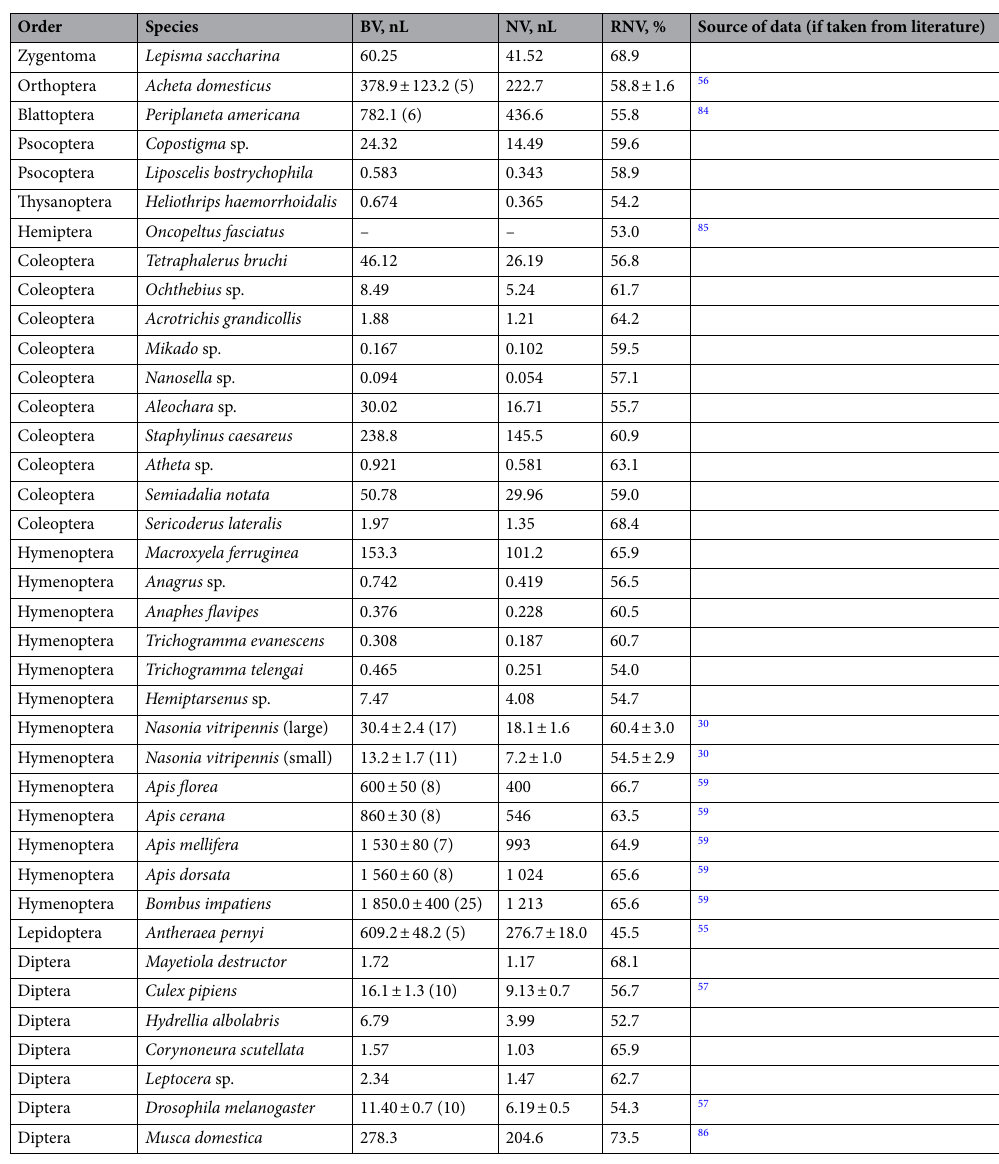
Table 1. Brain (BV) and neuropil volumes (NV) in insects (in cases of several measurements for one species, mean ± SD (n) are